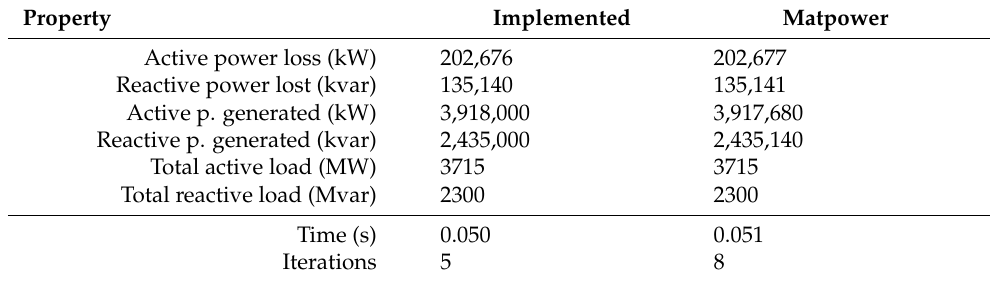
Table 2. Results of the 33-bar network.